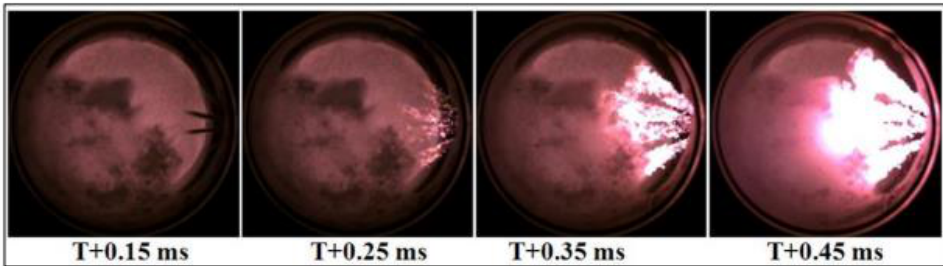
Figure 15. Images taken in the swirl environment chamber.